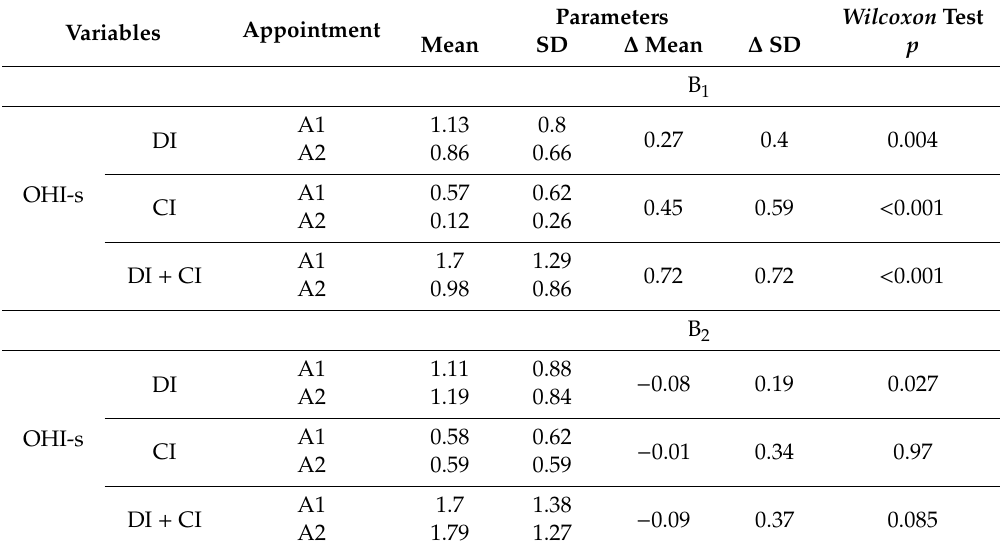
Table 3. Results of the Wilcoxon test for the OHI-s index and its components: DI and CI.